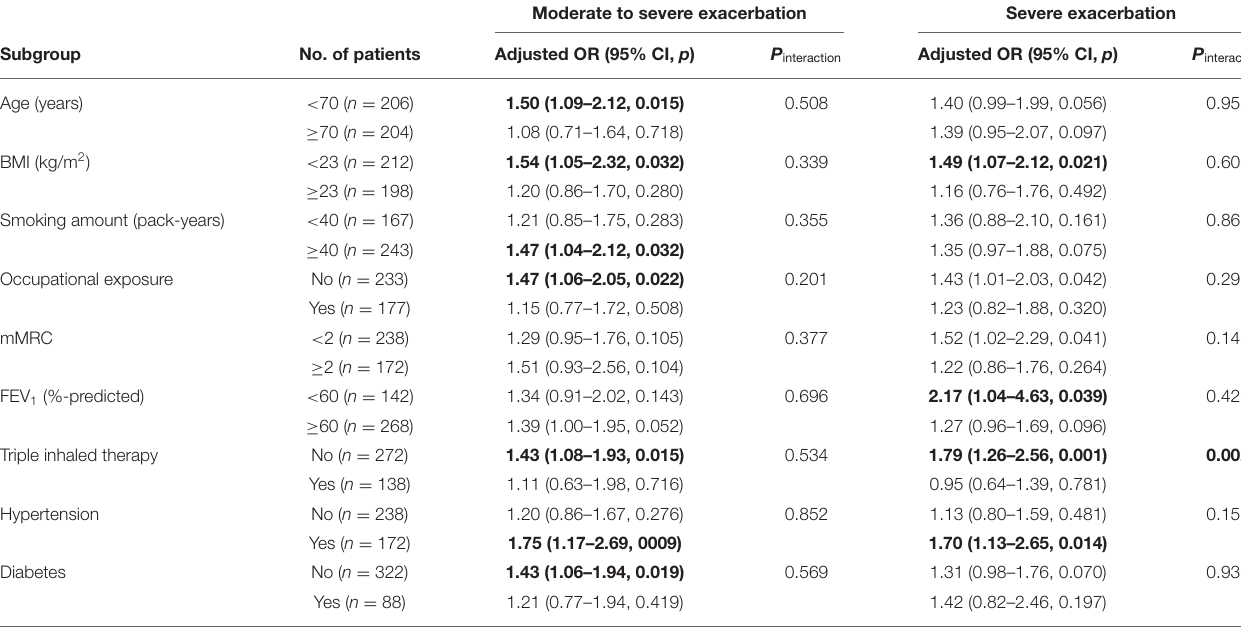
TABLE 4 | Subgroup analysis of the RV/TLC ratio and the risk of COPD